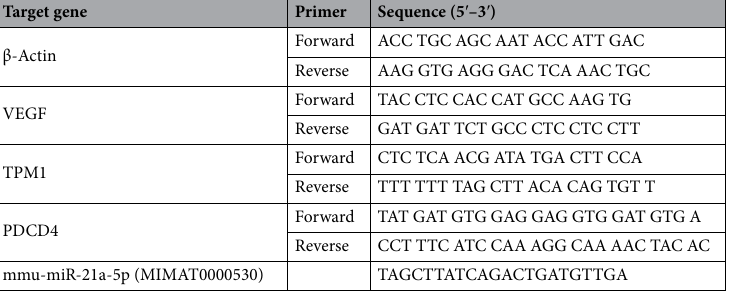
Table 1. Primers used in this